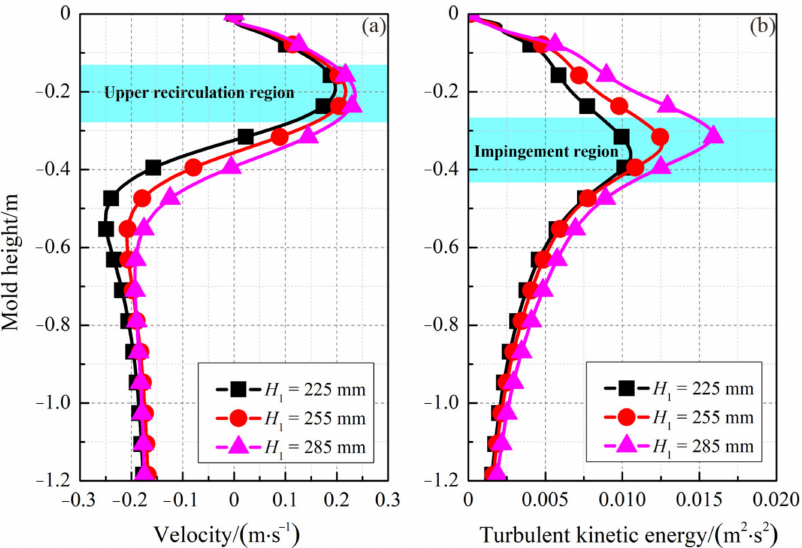
Figure 14. Velocity and turbulent kinetic energy profiles along mold height direction ( X = 0.695 m, Y = 0 m) with different positions of the ruler EMBr: ( a ) vertical velocity and ( b ) turbulent kinetic